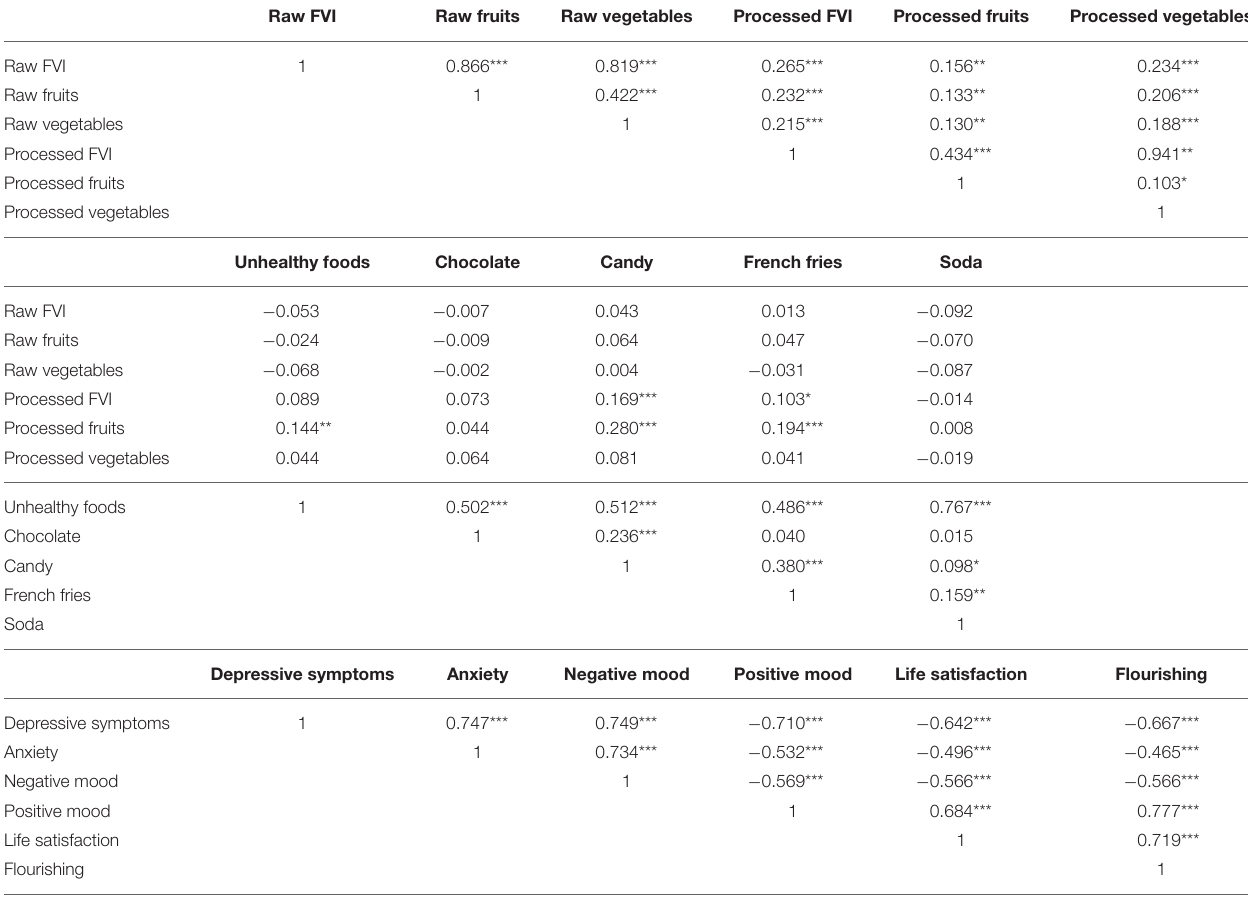
TABLE 3 | Inter-correlations among the fruit, vegetables, unhealthy foods, and mental health measures. Raw FVI Raw fruits Raw vegetables Processed